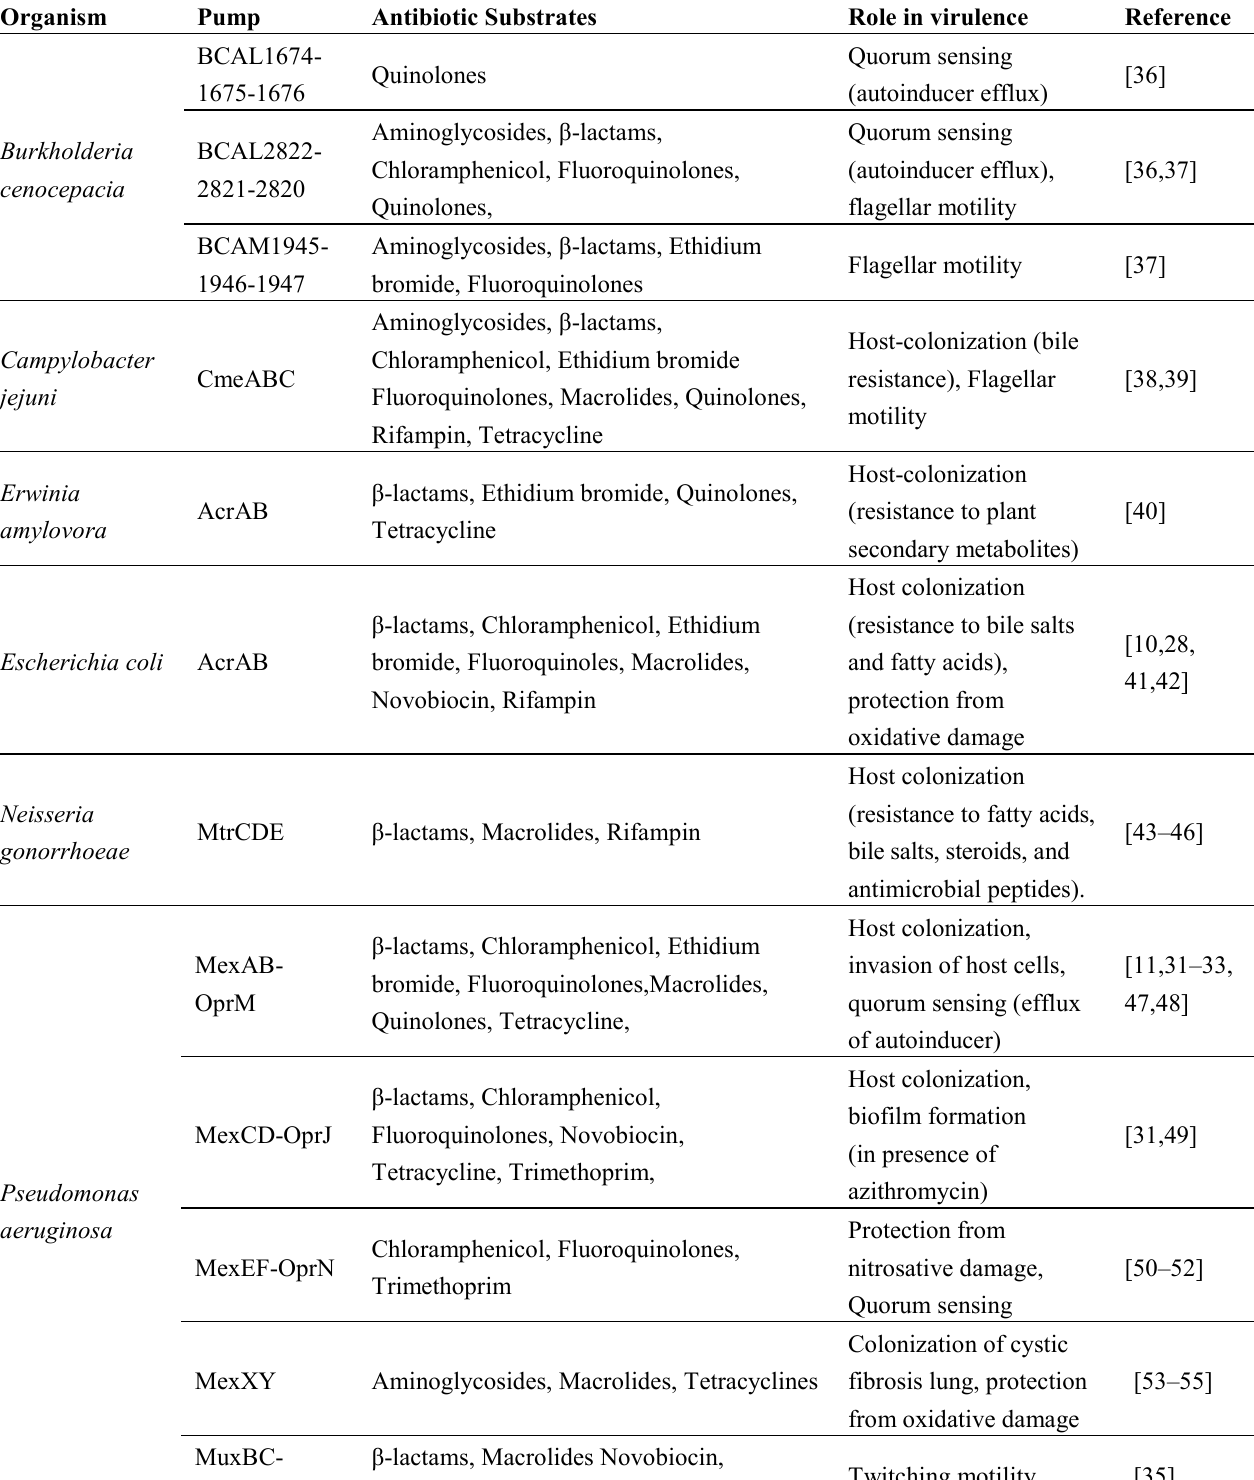
Table 1. Examples of Resistance-Nodulation-Division (RND) pumps from Gram-negative species with their antibiotic substrates and proposed physiological